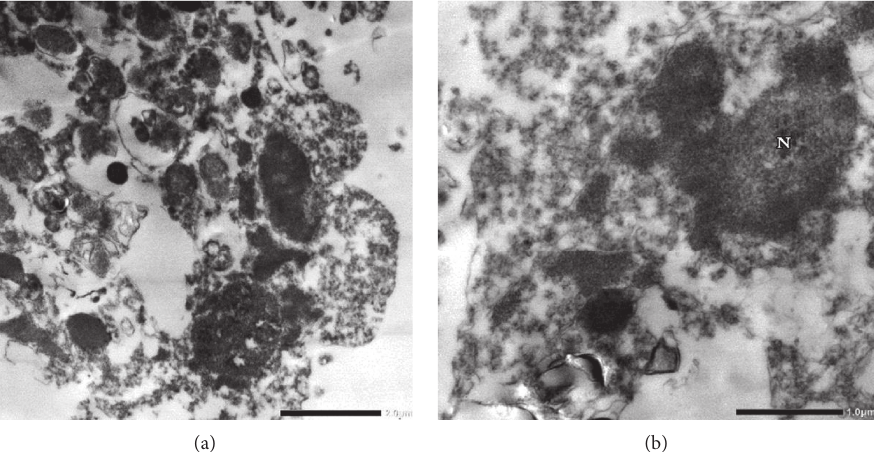
Figure 6: (a) Electron micrograph of imidacloprid-treated cells (0.0023 mM) illustrates destructed cell’s organelles and no cellular membrane appeared (F 4 G 1 -OsO 4 fixed-uranyl acetate lead citrate stained preparation, 4000x). (b) High magnification at 8000x shows nuclear-destructed